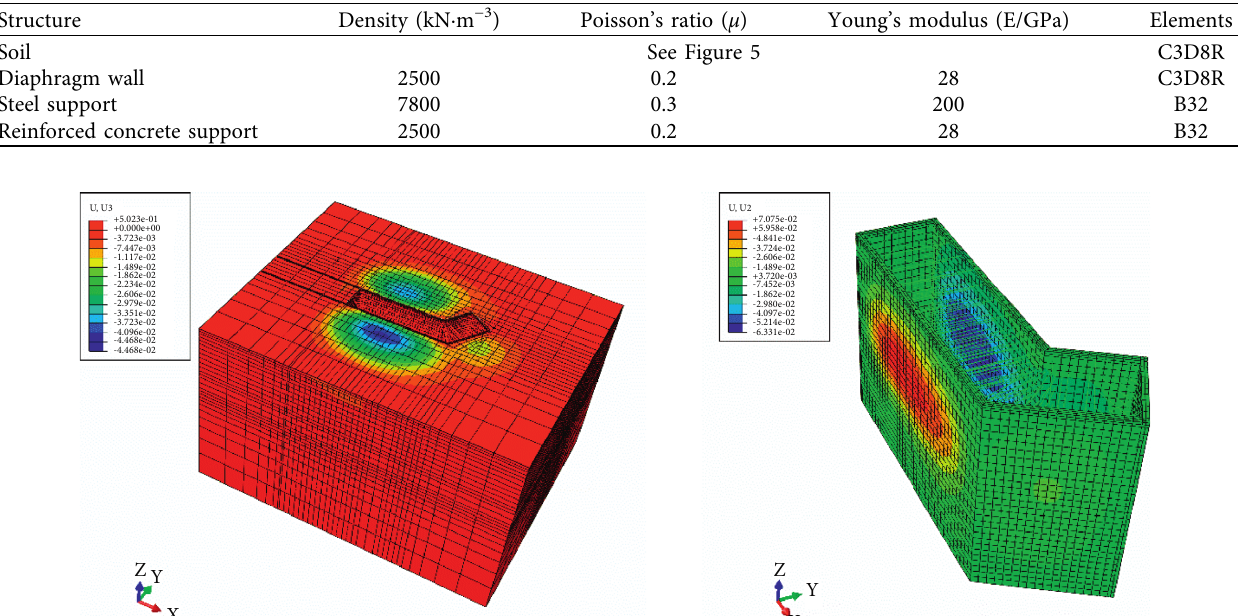
Figure 17: Finite element calculation results: (a) surface settlement and (b) diaphragm wall.